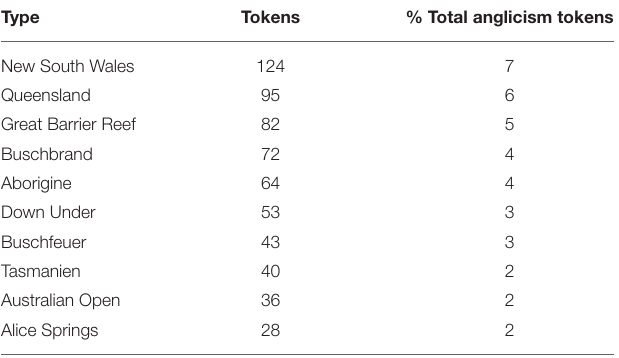
Each item also includes plural and genitive forms, rounded to the nearest whole number.